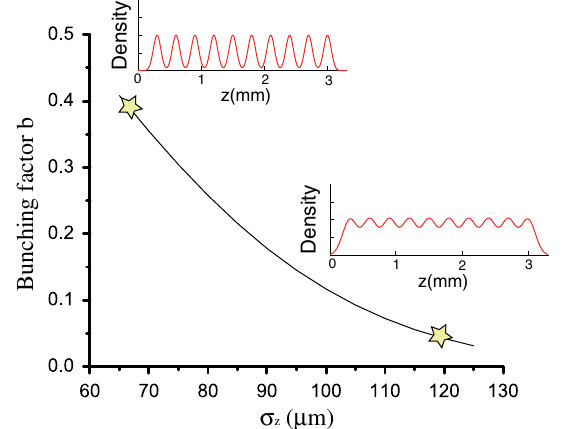
FIG. 2. Bunching factor for a beam distribution generated superimposing 20 Gaussian pulses separated by 300 (cid:7) m as a function of the single pulse rms width.